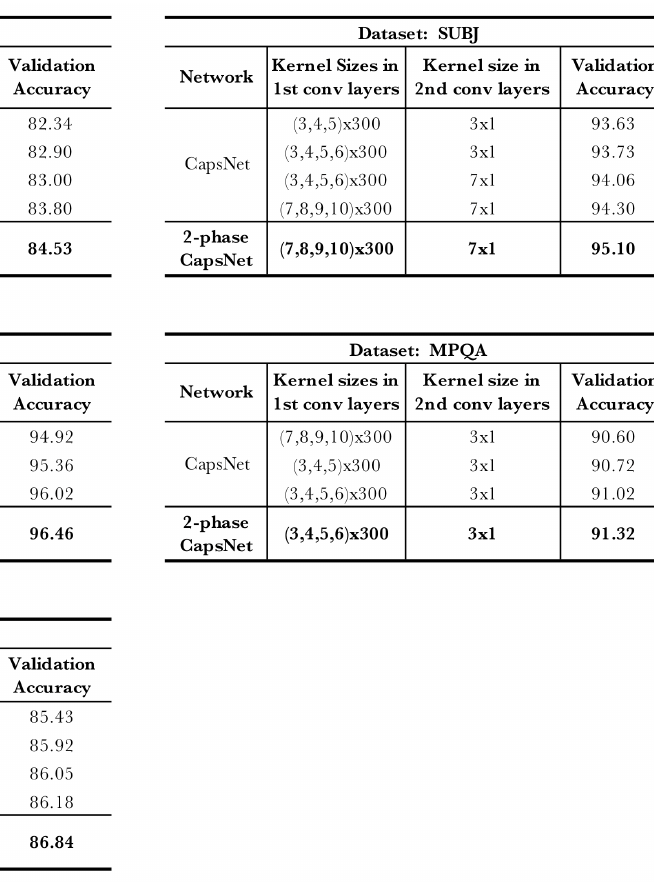
Figure 5. Effect of kernel sizes and the number of parallel convolution